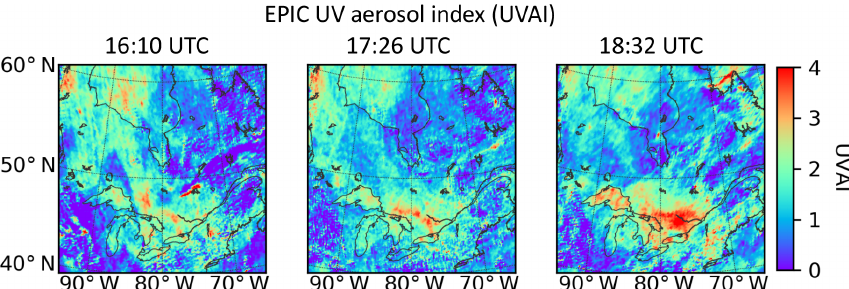
Figure 11. EPIC UV aerosol index (UVAI) for the three scenes on 25 August 2017 shown in Fig. 7. Here the UVAI was obtained from EPIC level 2 UV aerosol